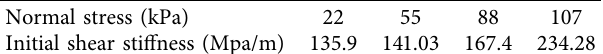
Figure 5: Contact surface shear test τ - Table 1: Initial shear stiffness values under different normal stresses.